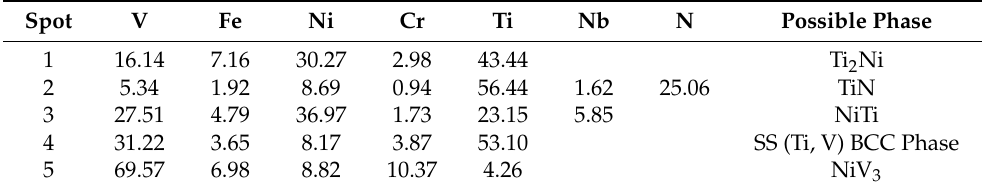
Table 2. EDS (at.%) analysis of the CPTi/V/Inconel 718 joint. The position of the EDS analysis indicated in Figure